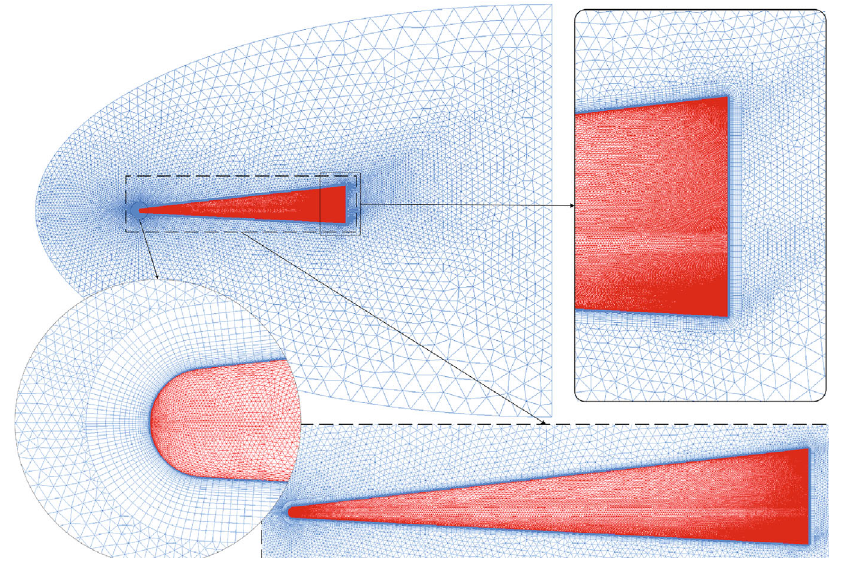
Figure 4: Mesh of the